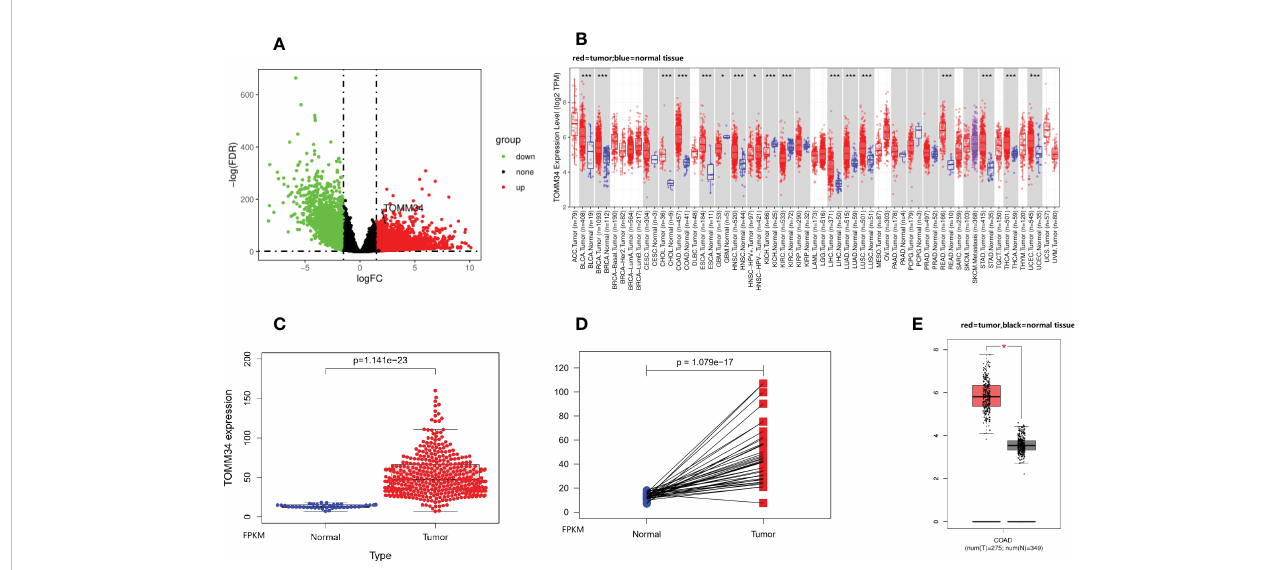
FIGURE 1 TOMM34 expression analysis in colon cancer. (A) Volcano plot showing gene expression. (B) TOMM34 expression in divergent types of cancer, indicating that TOMM34 is highly expressed in a variety of cancers. (C) TOMM34 expression was elevated in tumor tissues compared with normal tissues obtained from the TCGA-COAD dataset, suggesting that the expression of TOMM34 was increased in tumor tissue. (D) TOMM34 expression in tumor tissues and paired normal tissues obtained from the TCGA-COAD dataset, suggesting that the expression of TOMM34 was increased in tumor tissue. (E) TOMM34 expression in tumor tissues and normal tissues obtained from the GEPIA database, suggesting high expression of TOMM34 in tumor tissue.